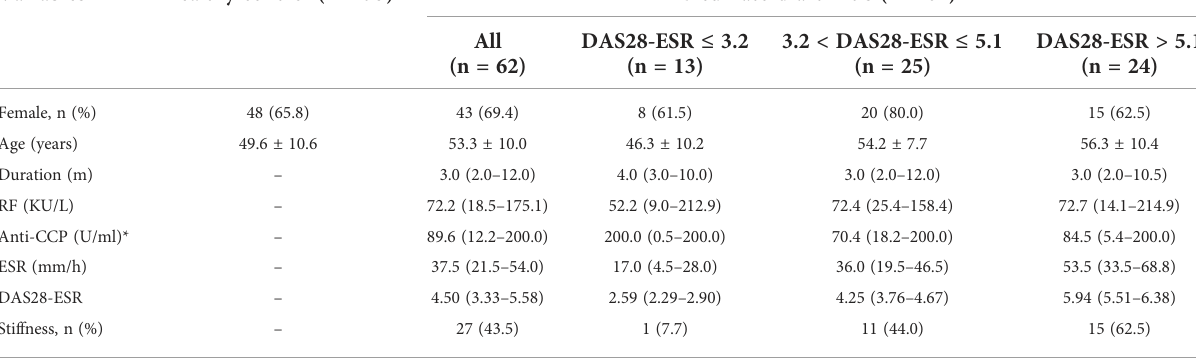
TABLE 1 Clinical characteristics of RA patients and controls.